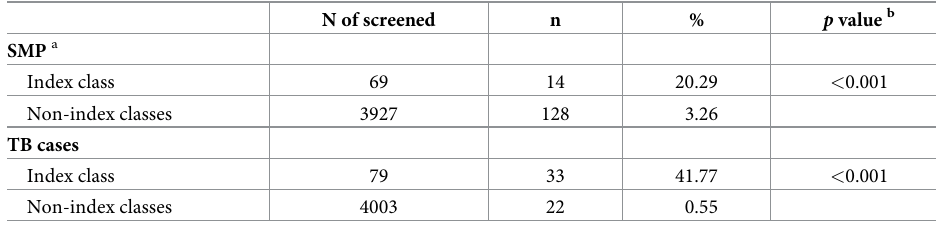
Table 1. SMP and TB cases of students in different